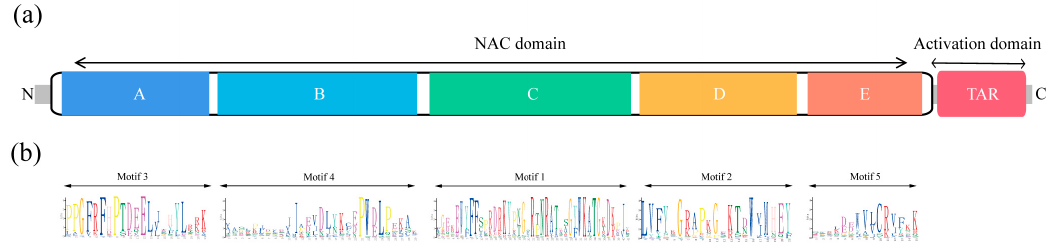
Figure 3. NAC domain and TAR in D. catenatum NAC family protein. ( a ) The predicted domains in the N-terminus and C-terminus. The NAC domain consists of subdomains A to E. The TAR (transcriptional activation region) is the C-terminal activation domain. ( b ) Alignment of the NAC domain from the MEME results for the DcNACs. The motifs 3, 4, 1, 2, and 5 form the putative DcNAC NAC domain.